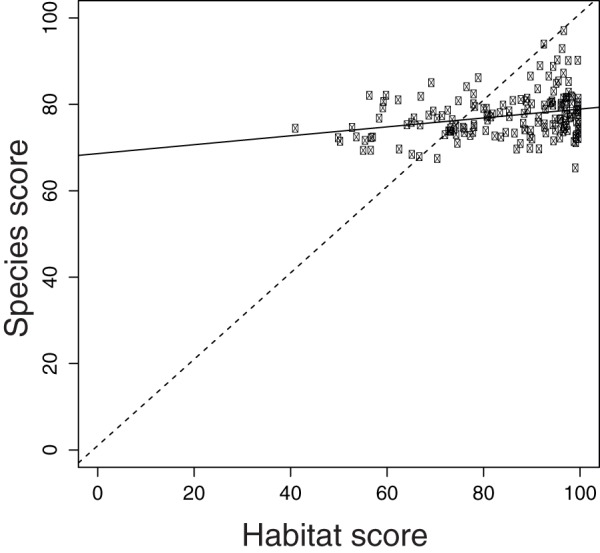
Relationship between habitat and species scores for all EEZ regions.Dashed line represents a 1:1 relationship. Solid line is the regression line. (R-squared  = 0.07; p-value  = 0.0004).